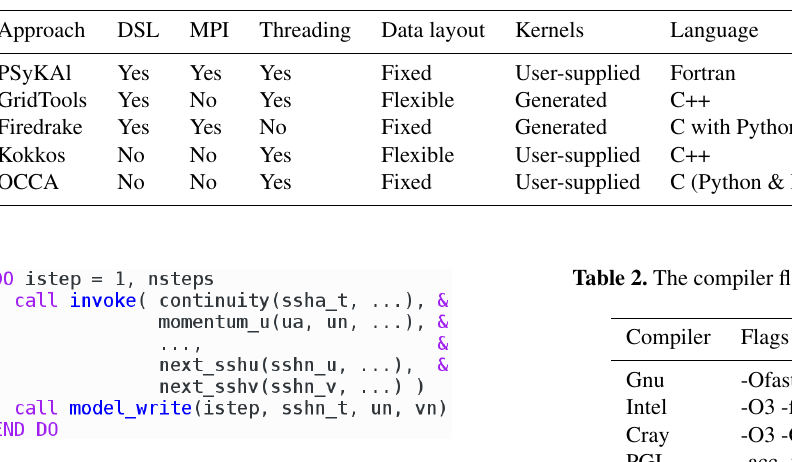
Figure 1. A schematic of the top-level of the PSyKAl version of the NEMOLite2D code. The kernels listed as arguments to the invoke call specify the operations to be performed.